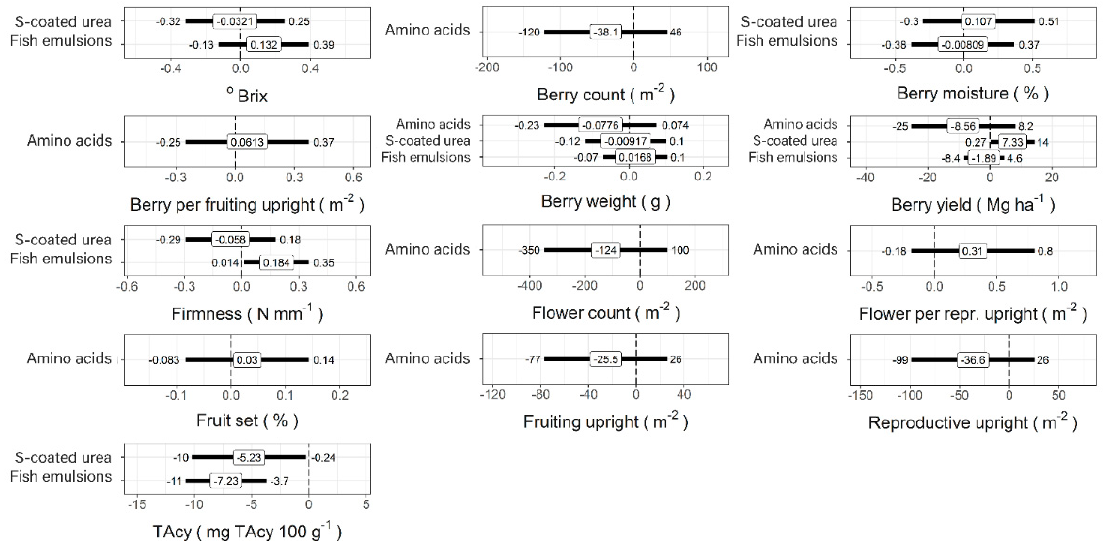
Figure 2. Coefficients of the linear mixed model on the x axes showing the effects on berry yield and quality of amino acids (8-0-0), sulfur-coated urea (24-5-11), and fish emulsions (6-1-1) compared to ammonium sulfate (21-0-0) (y axes). The in-box black line shows 95% confidence intervals. The on-line values are the mean and lower and upper limits for 95% confidence intervals.